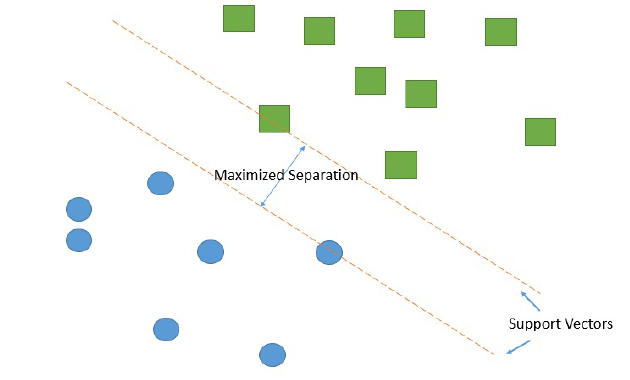
Figure 2. Support vector machine: maximum separation between two